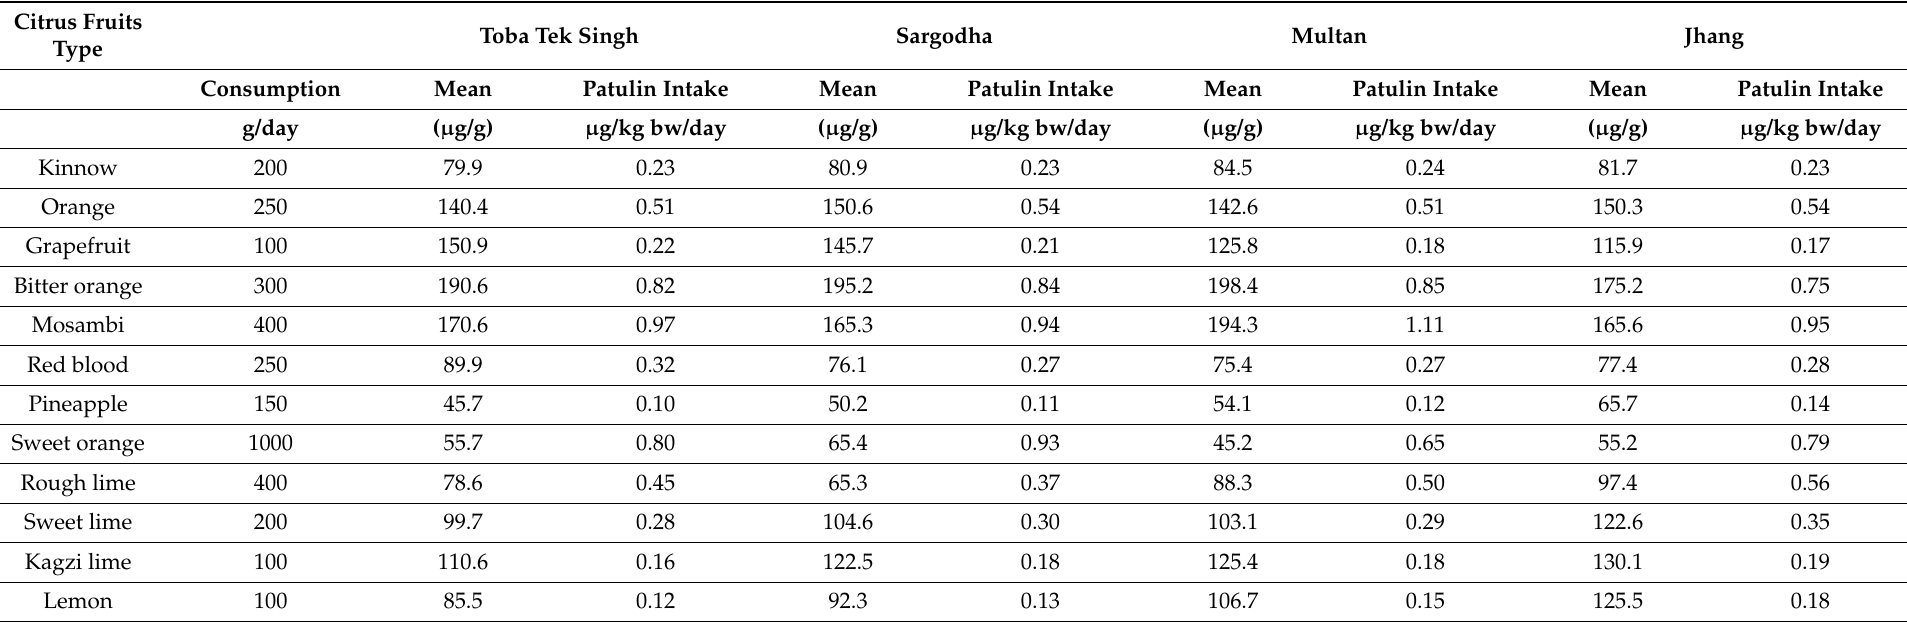
Table 5. Dietary intake of patulin in citrus fruit samples from central cities of Punjab,